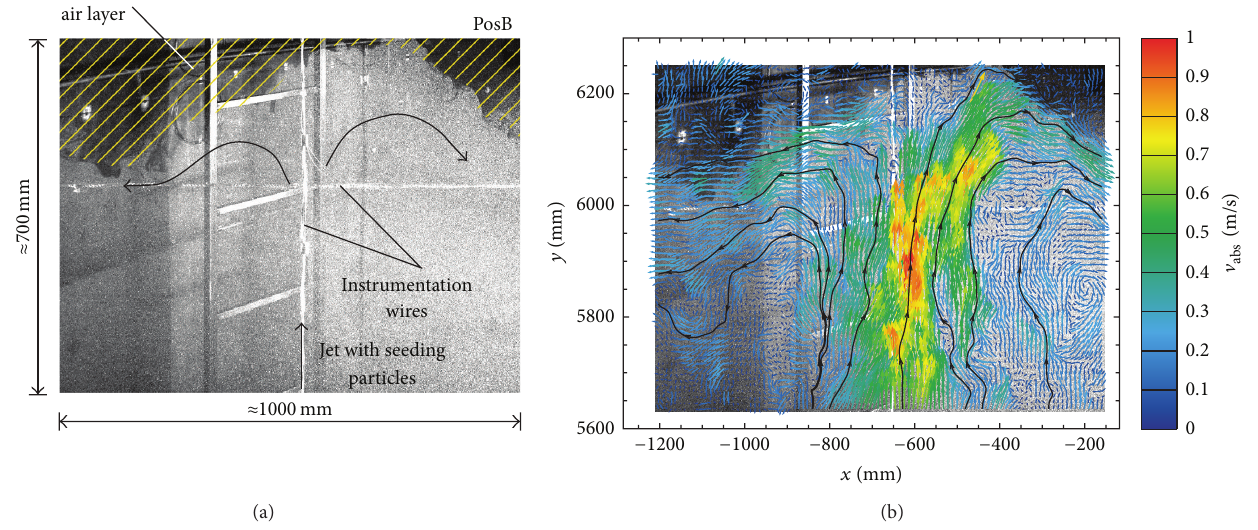
Figure 2: Example of a PIV raw image recorded for position B showing the seeded jet in the lower part, the nonseeded helium-rich air layer at the top, and parts of the instrumentation wires (a) and the corresponding instantaneous velocity field with selected stream lines (b). Dimensions are given in mm.